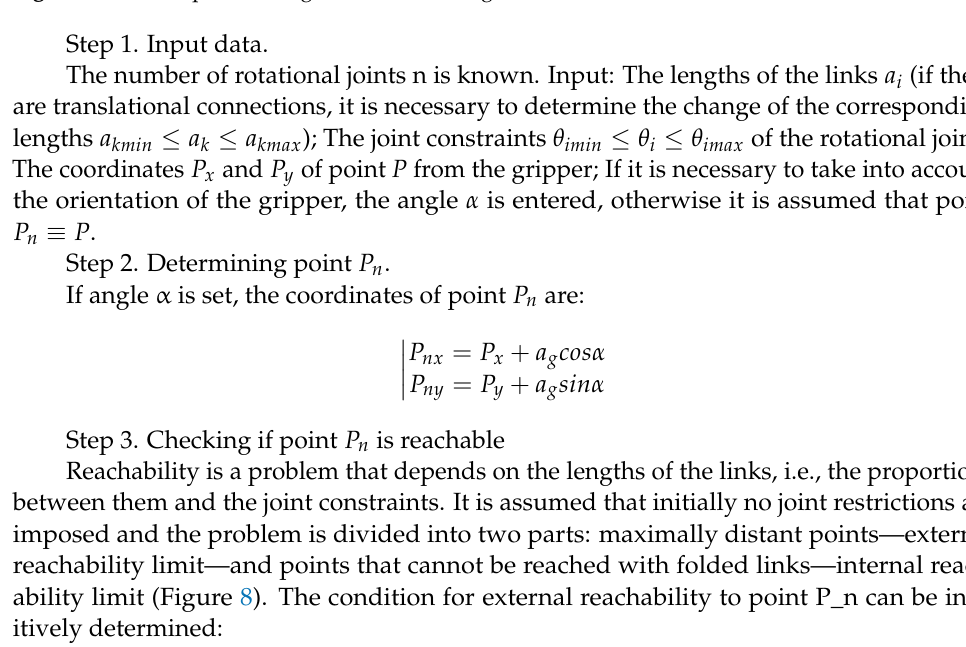
Figure 7. Basic steps of the algorithm for solving IK.